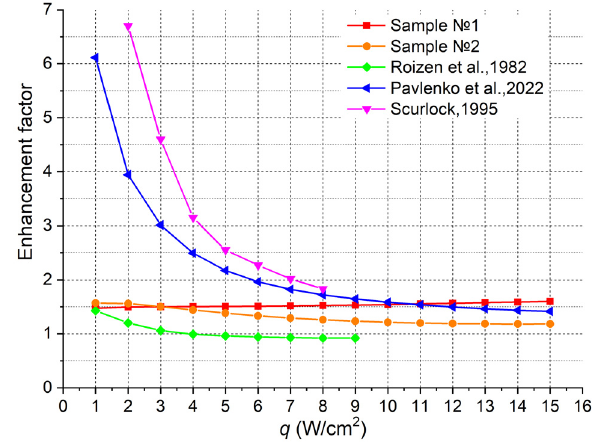
Figure 9. Comparison of data from various studies on the heat transfer enhancement during nitrogen boiling on modified heaters at atmospheric pressure.